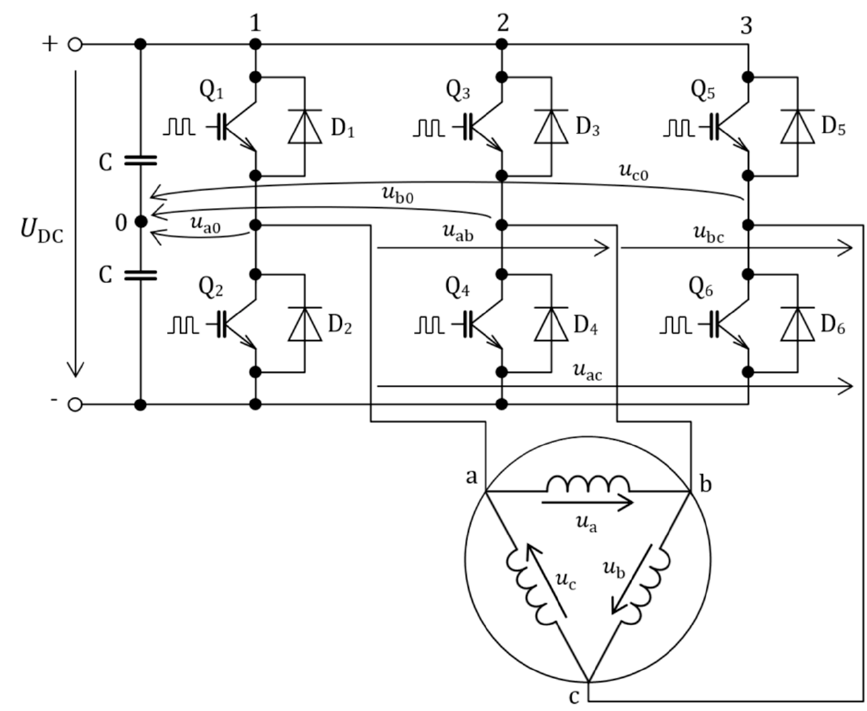
Figure 2. Inverter supplying a delta-connected machine.